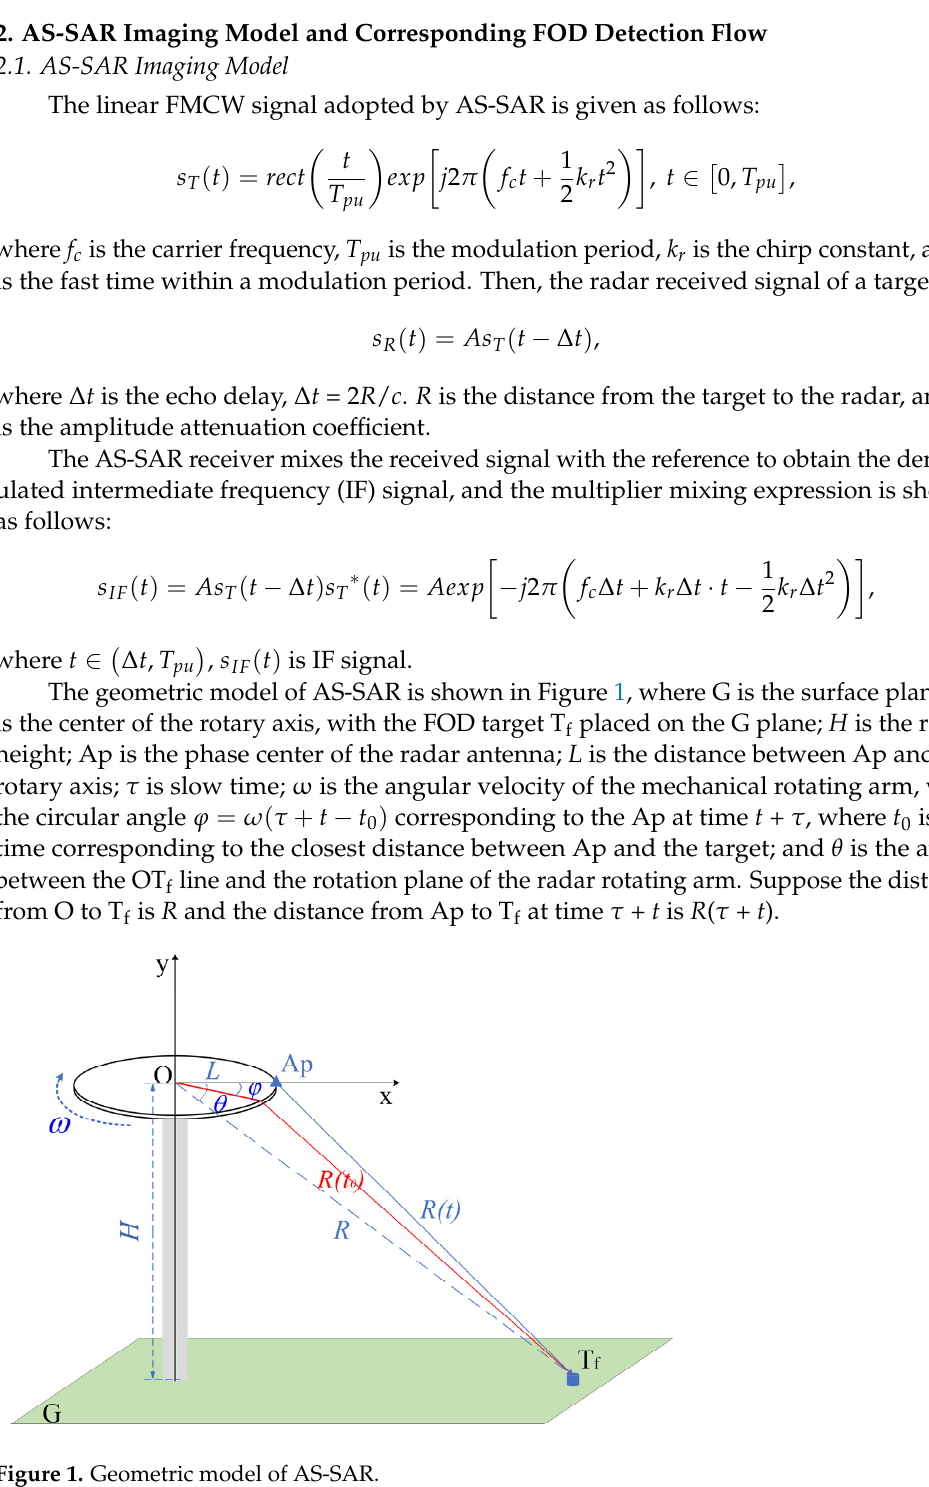
Figure 1. Geometric model of